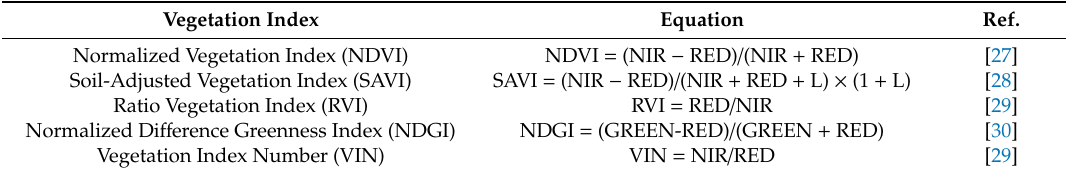
Table 2. Vegetation indices used for the perennial ryegrass ground cover estimation.